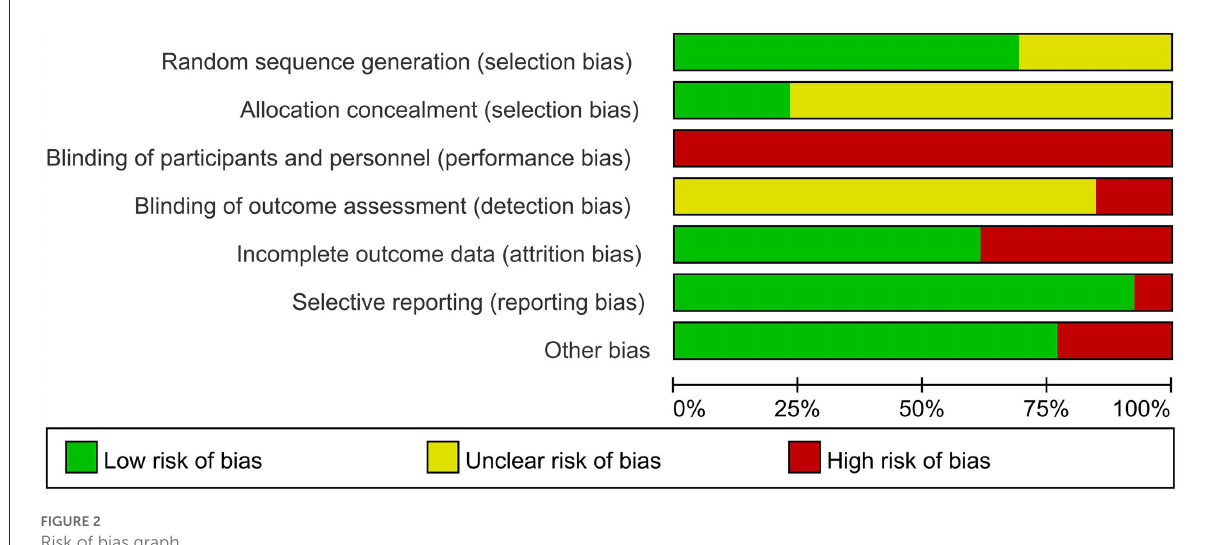
FIGURE2 Risk of bias